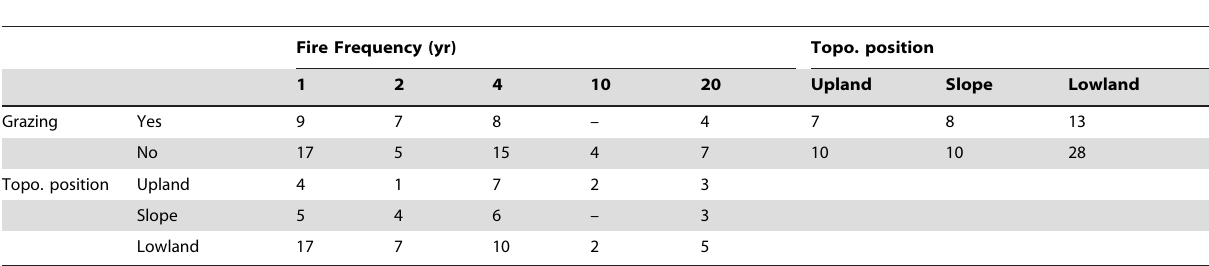
Table 1. Shrub island sample sizes among landscape